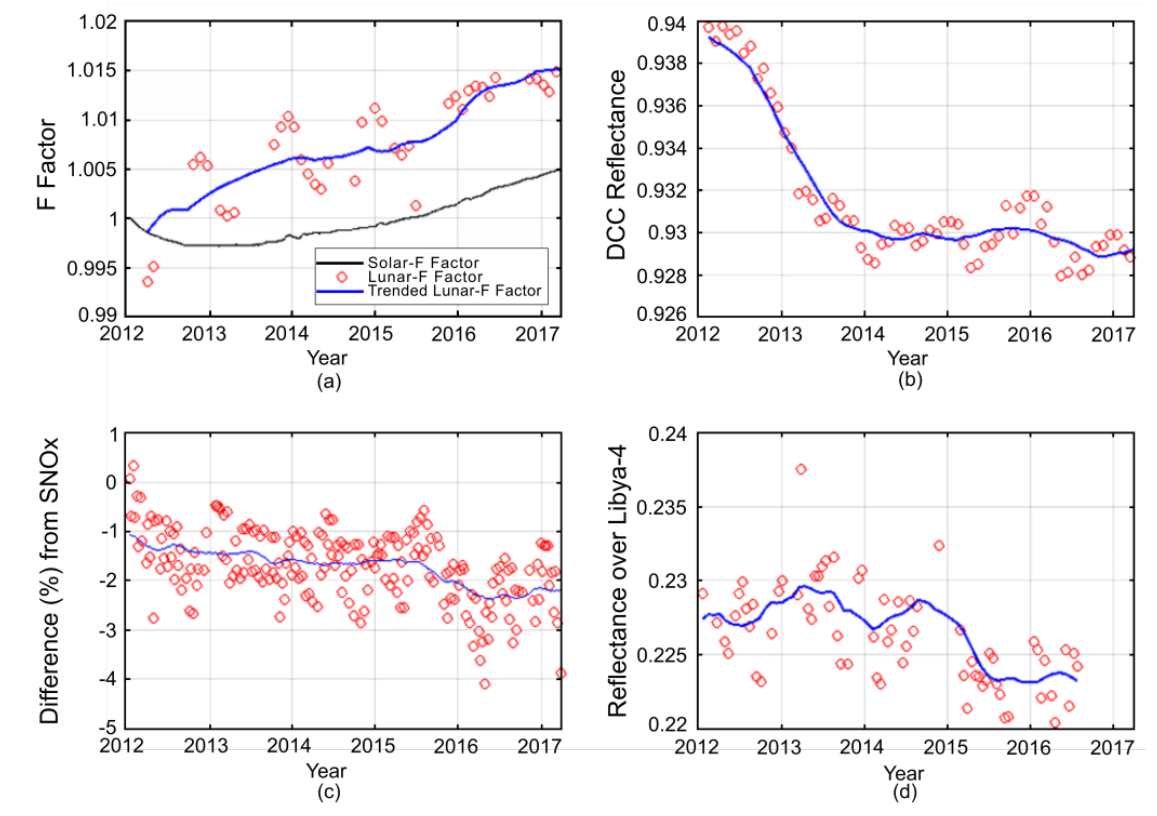
Figure 3. Five types of time series of VIIRS sensor radiometric performance monitoring measurements analyzed with trends illustrated using VIIRS M2 as an example. ( a ) The solar-F and lunar-F factor time series. ( b , d ) Time series of top-of-the-atmosphere (TOA) reflectance over Deep Convective Clouds (DCC) and Libya, respectively. ( c ) The percent difference in VIIRS M2 w.r.t. MODIS from SNOx; blue curve in each panel shows the trend in stability-monitoring measurement data after the preprocessing. Table 3. Characteristics of Calibration Stability Monitoring Methods for VIIRS